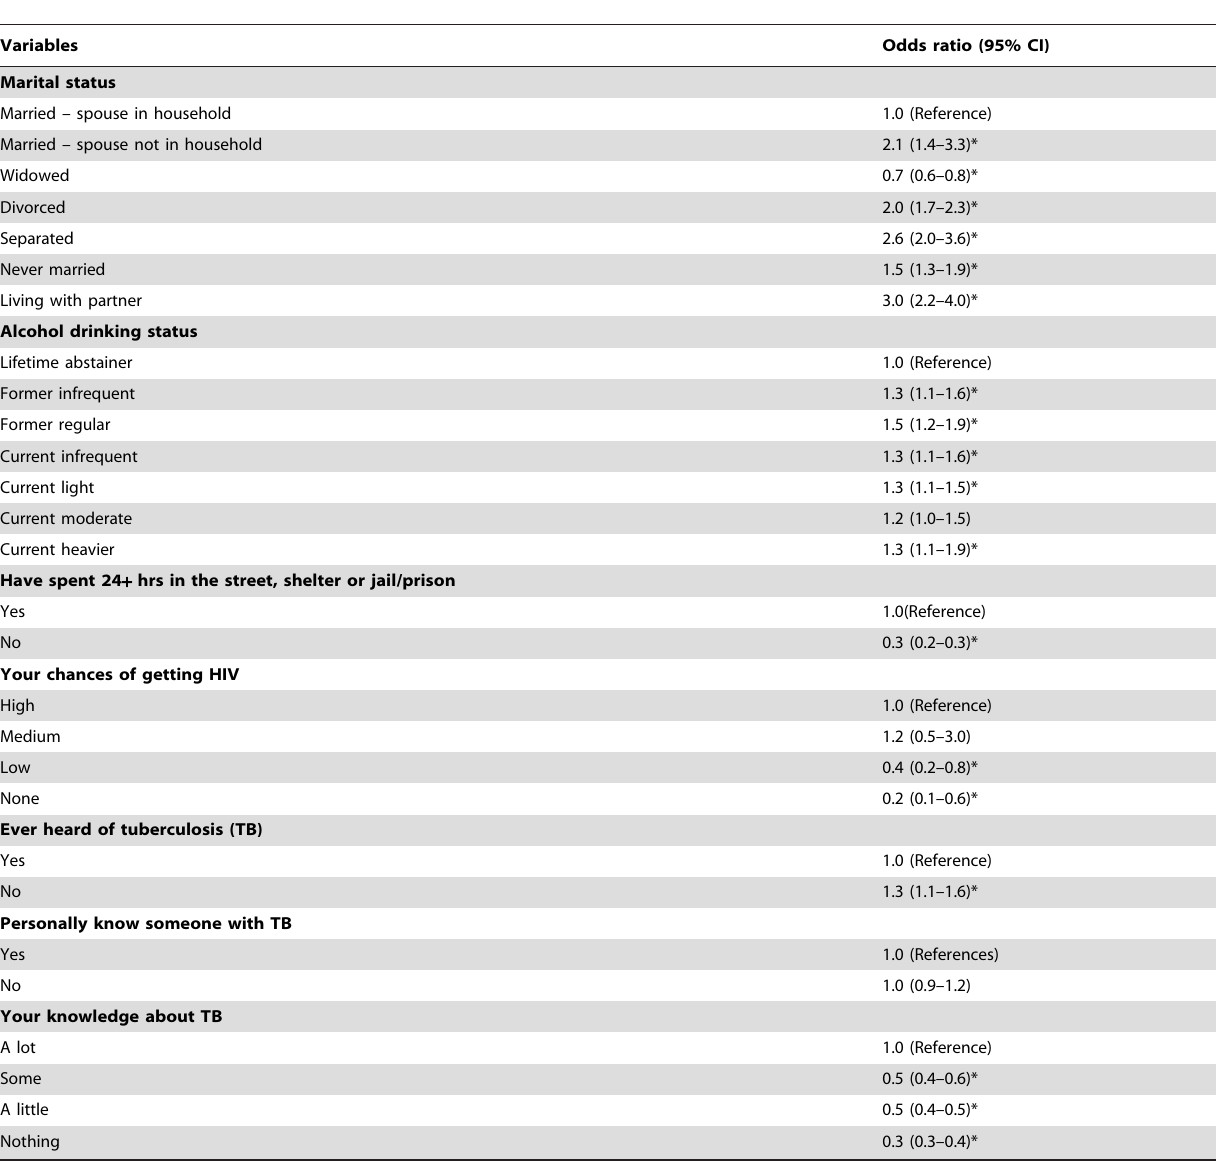
Table 4. Results of multiple logistic regression models for ever been tested for HIV adjusted for sex, race, Medicare type, health insurance coverage status, and physical health